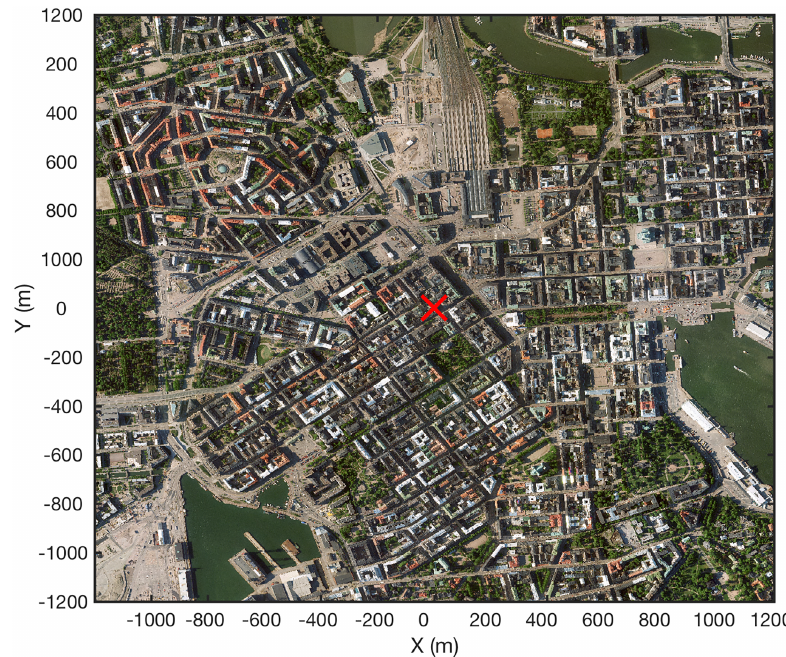
Figure 1. Aerial image of central Helsinki (Kaupunkimittausosasto, Helsinki, 2011). Hotel Torni is marked with a red cross.